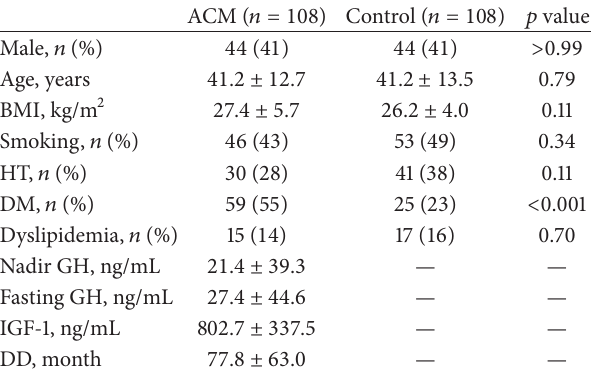
Table 1: Demographic, clinical, and endocrine characteristics.